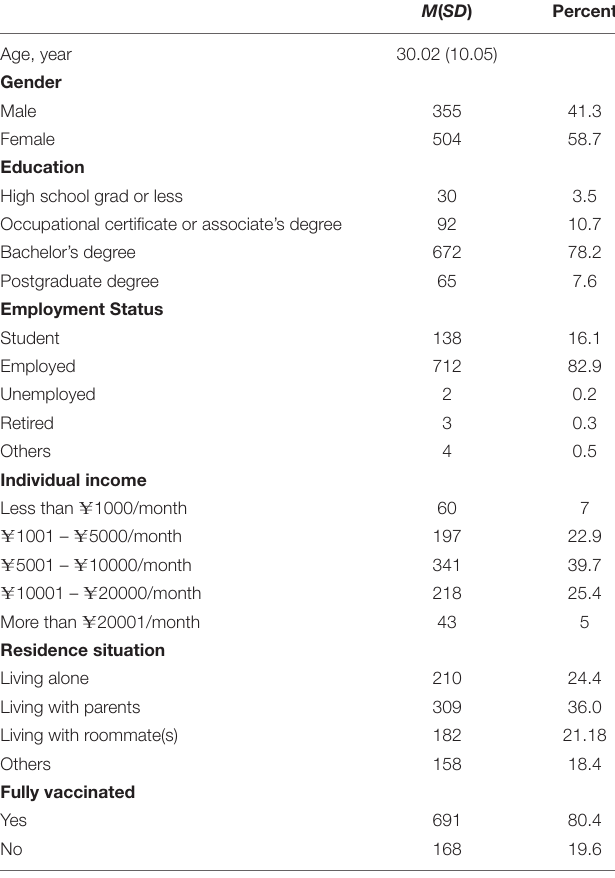
TABLE 1 | Sample characteristics ( N =